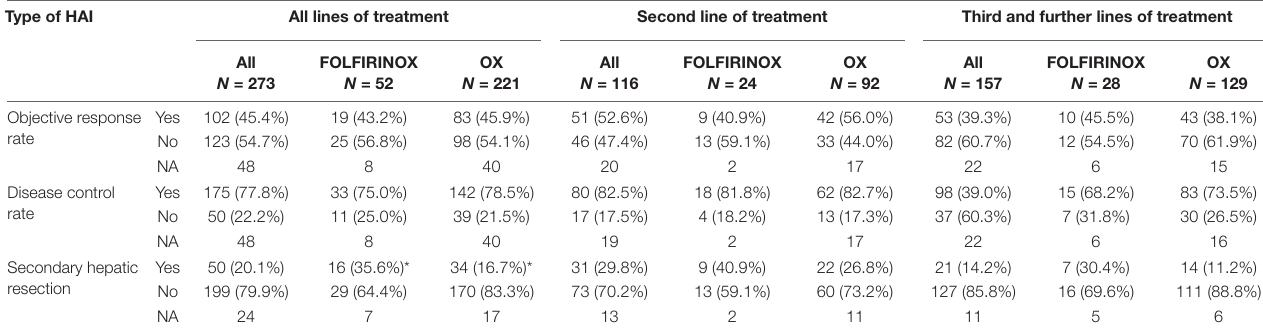
TABLE 3 | Treatment efficacy: best response rates. Type of HAI All lines of treatment Second line of treatment Third and further lines of treatment All N = 273 Objective response rate Disease control rate Secondary hepatic Yes resection HAI, hepatic arterial infusion. *p < 0.05.